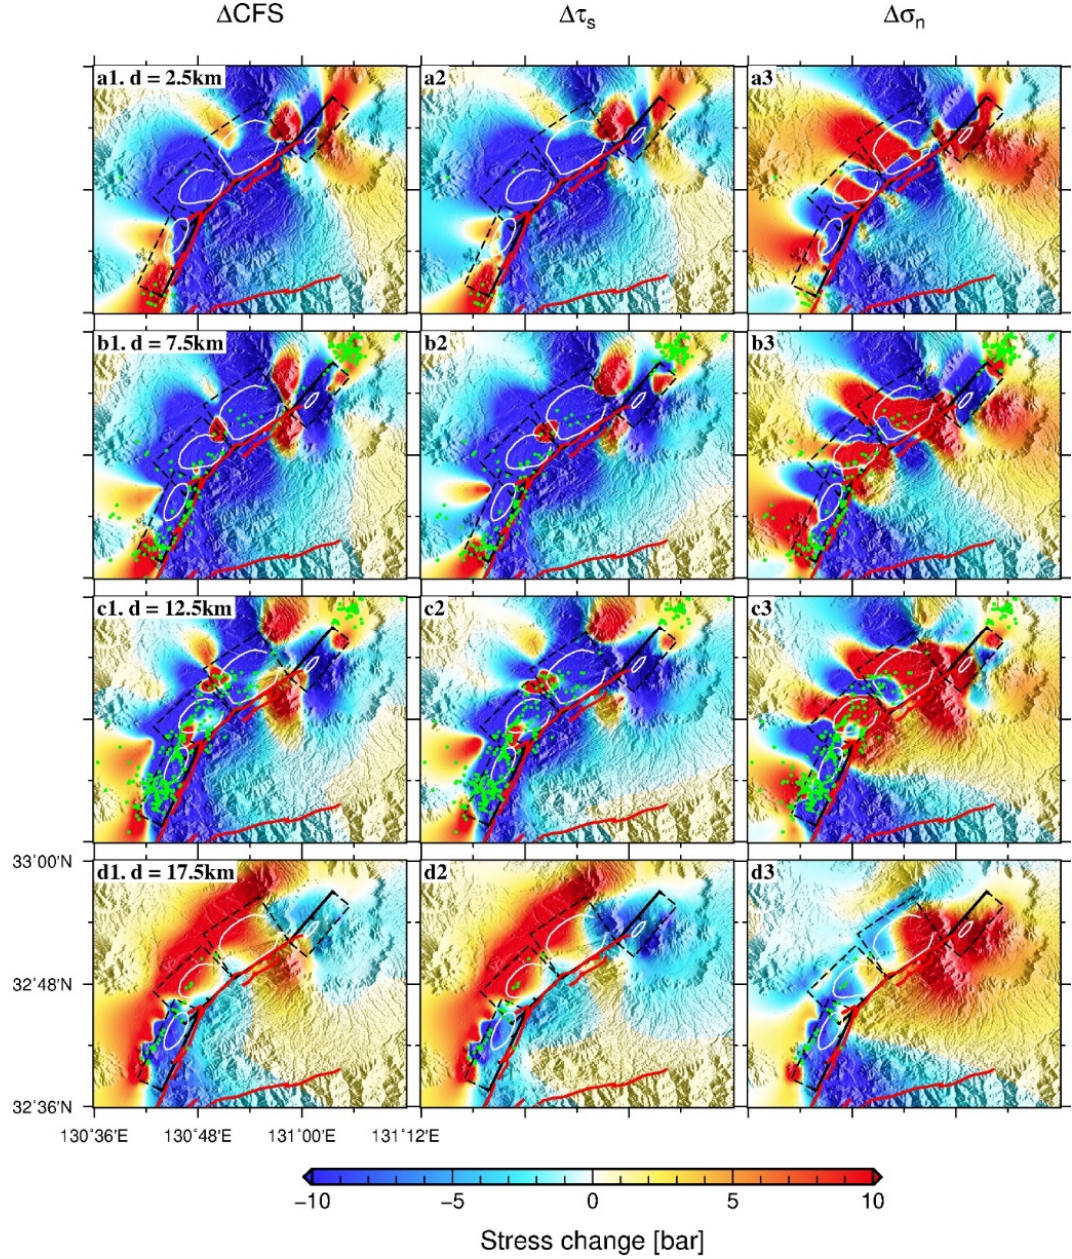
Figure 8. Static stress changes caused by the mainshock at different depths, calculated from the preferred model with μ (cid:4593) = 0.4 . ( a1–d1 ) show the static Coulomb stress changes (positive ΔCFS may promote failure); ( a2–d2 ) show the shear stress changes (positive in the direction of slip); ( a3–d3 ) show the normal stress changes (positive when the fault is unclamped). The receiver fault is approximately parallel to the seismogenic fault of the mainshock, with strike, dip, and rake of (220°, 68°, and –165°, respectively. Aftershocks with Mw >3.0 are denoted by green dots in each panel, with hypocenter depth ranges of d ± 2.5 km. The white contours highlight the asperities with a slip amplitude of over 2 m. The red lines show the active faults. The black dashed rectangles are surface projections of fault planes.